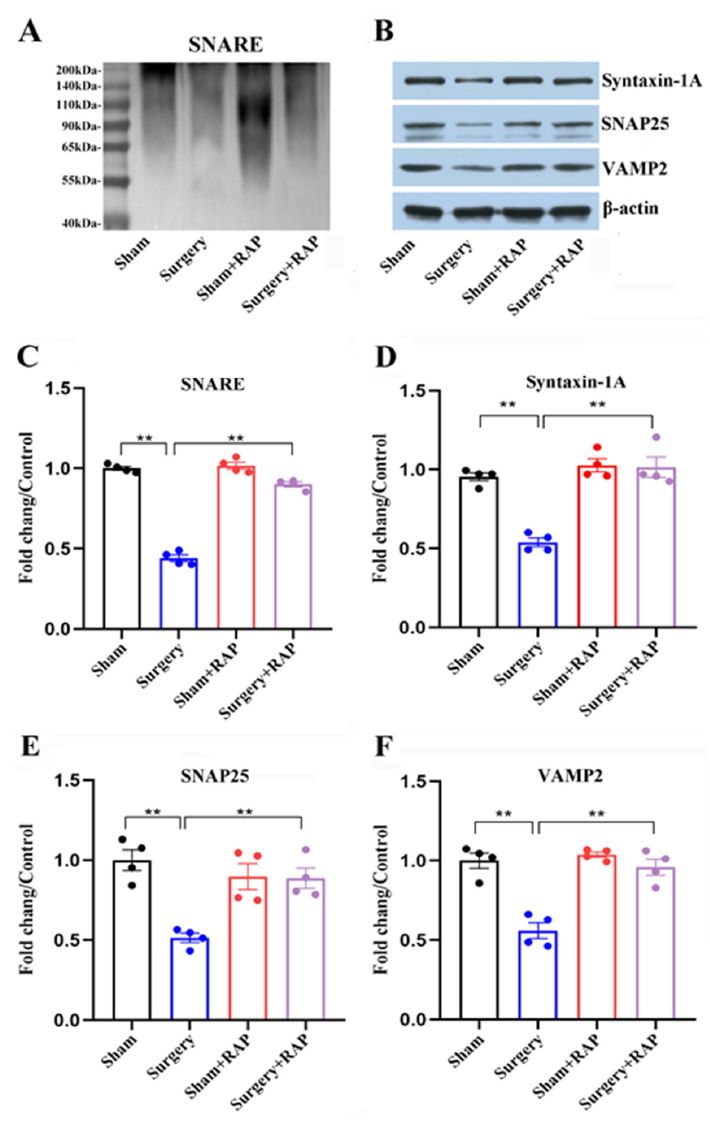
Figure 2. Rapamycin attenuated disturbances of SNARE proteins in synaptosomes following sur- gery. ( A , B ) Representative immunoblots illustrating SNARE ( A ) and its core proteins syntaxin 1A, SNAP25, and VAMP2 ( B ) in hippocampal synaptosomes. ( C ) Decreased SNARE complex levels in the surgery group compared with those in the sham group were reversed by rapamycin. ( D – F ) Ra- pamycin ameliorated surgery-induced decreases in levels of three core SNARE complex proteins: